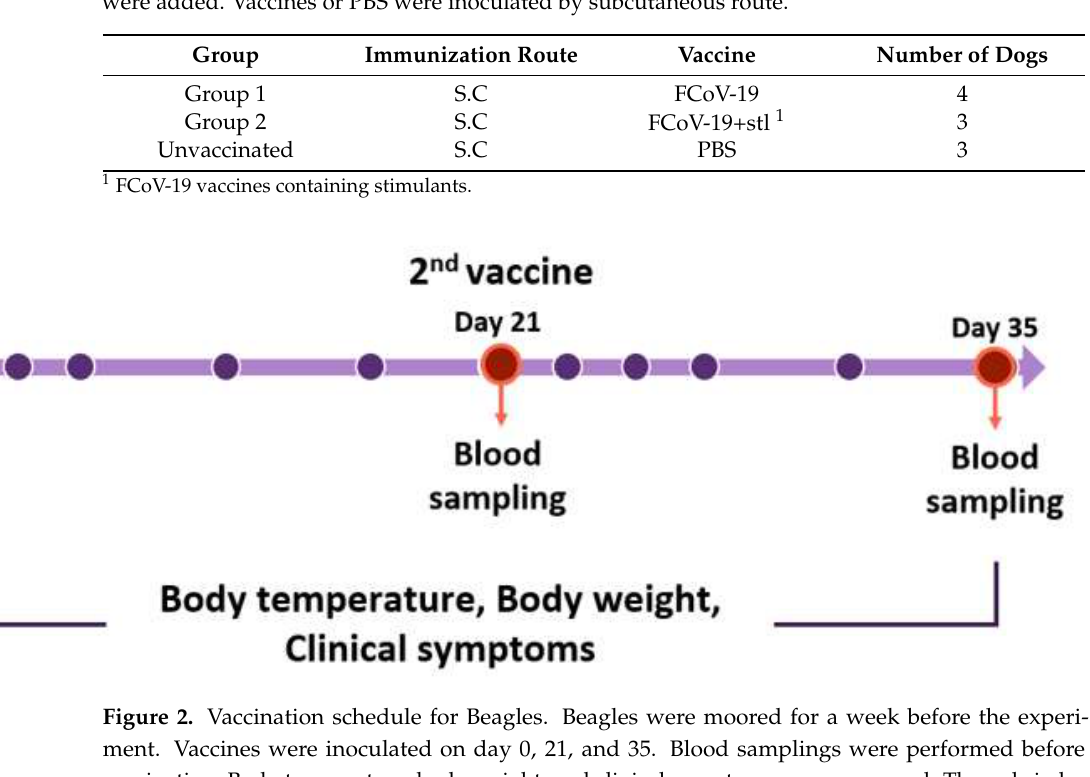
Table 2. Experimental design for immunization in beagle dogs offered by COVID-19 subunit vaccines. Vaccines used for Group 1 were composed of SARS-CoV-2′s S1, RBD protein, and adjuvants. Vaccines used for Group 2 were composed of SARS-CoV-2′s S1, RBD protein, and adjuvants and stimulants were added. Vaccines or PBS were inoculated by subcutaneous route.